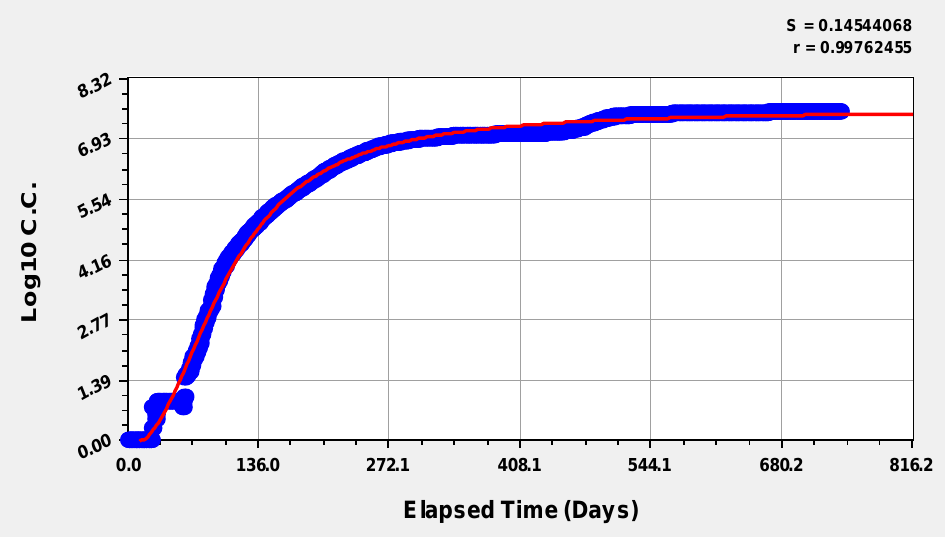
S = 0.07246079 r = 0.99914784